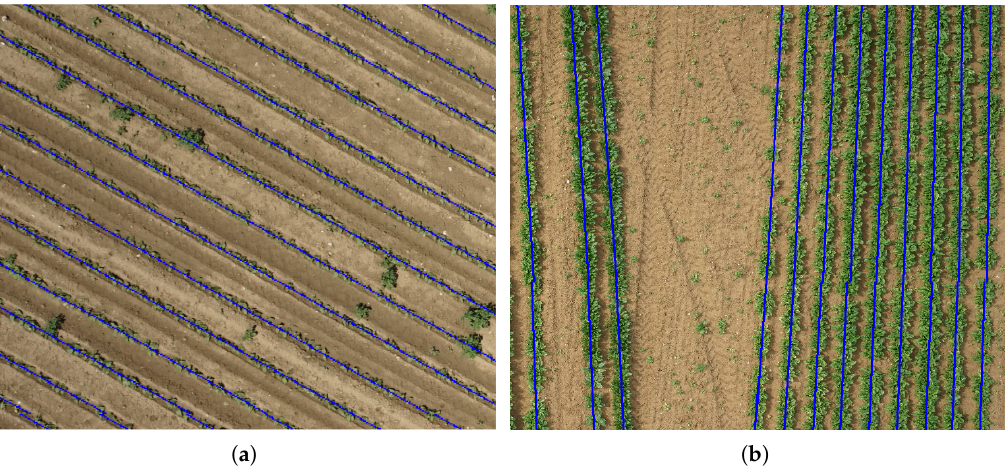
Figure 3. From left to right: line detection in bean ( a ) and spinach ( b ) fields. Detected lines are in blue. In the spinach field, inter-row distance and the crop row orientation are not regular. The detected lines are mainly located in the center of the crop